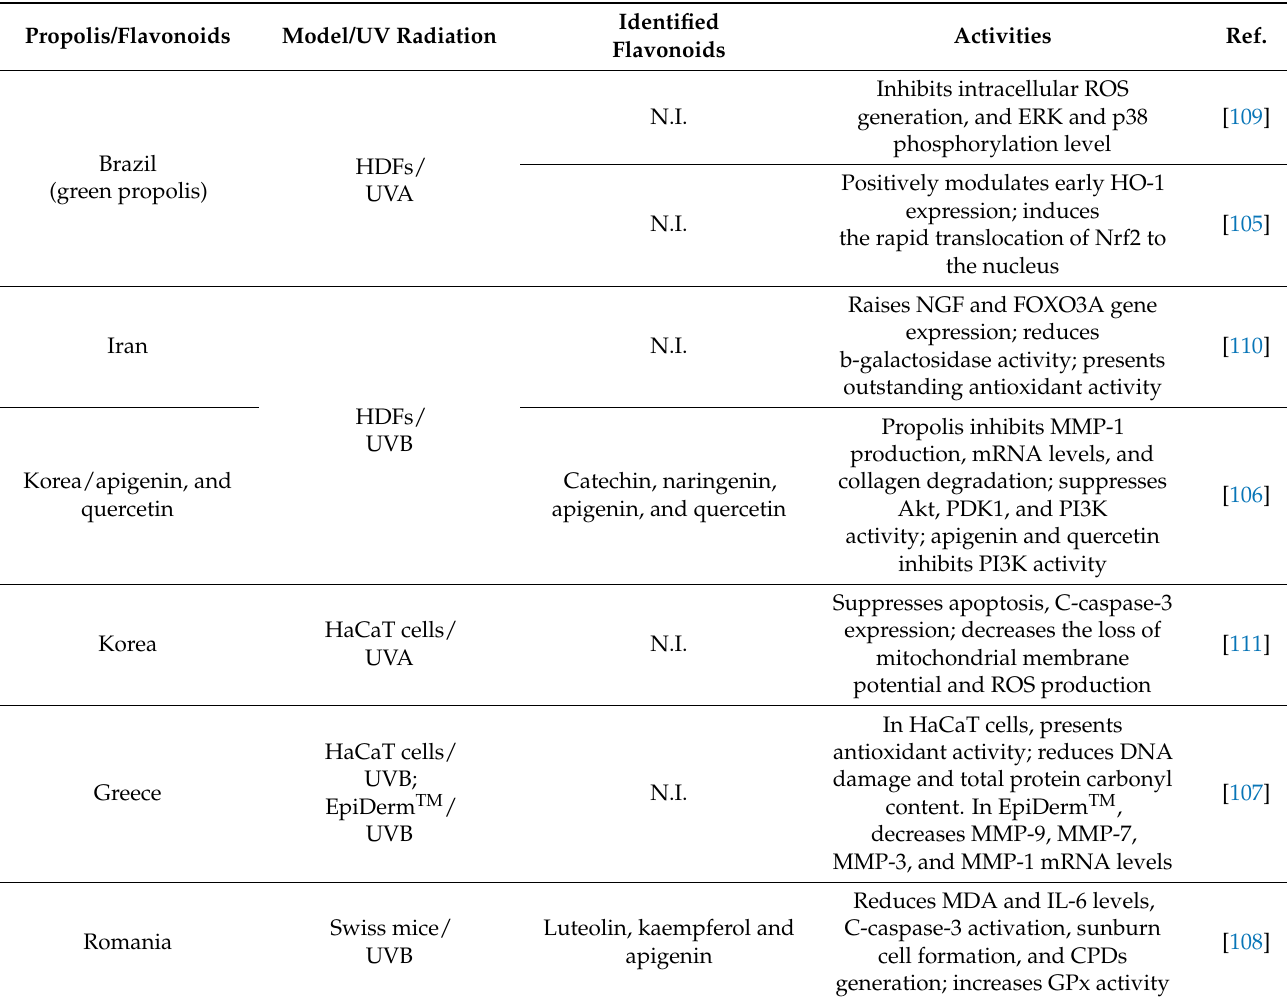
Table 5. Propolis from different countries and some of its identified flavonoids with anti-photoaging